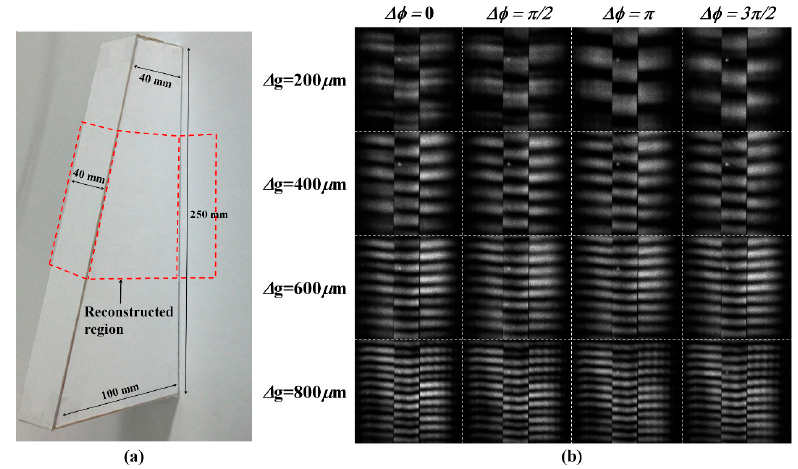
Figure 11. ( a ) Photographic image of the slanted object used for the 3D depth extraction; ( b ) CCD images of the distorted fringe patterns projected on the slanted object.